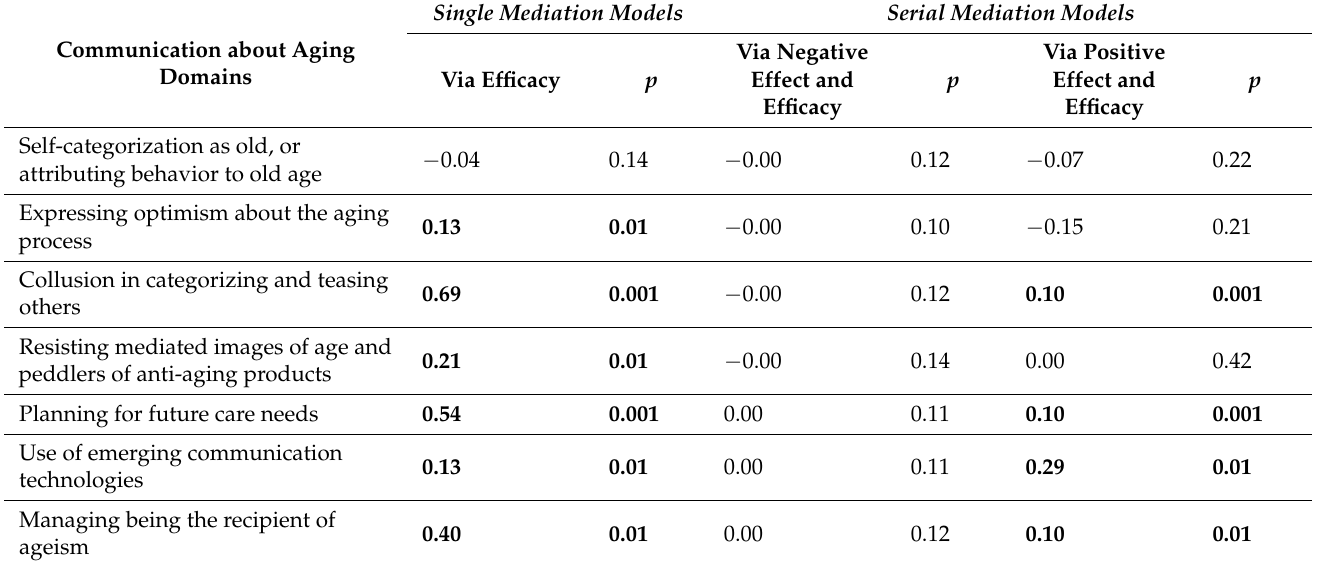
Table A6. Summary of standardized indirect effects.